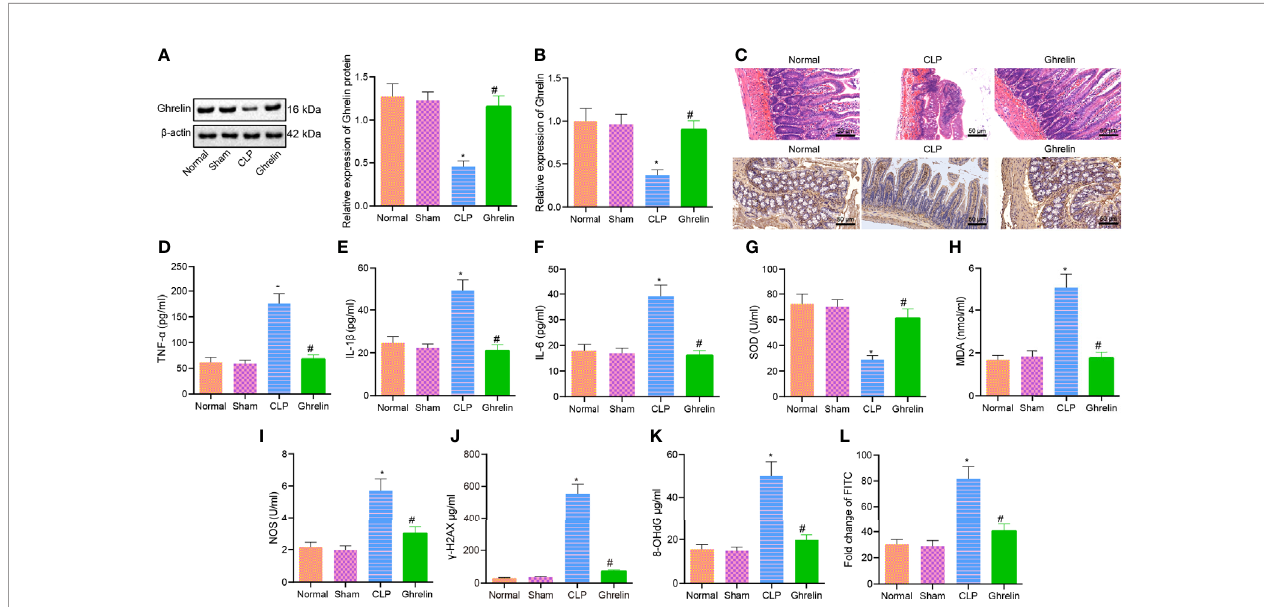
FIGURE 2 | Exogenous Ghrelin inhibits the occurrence of intestinal dysfunction in sepsis. (A) , Ghrelin expression in small intestine as examined by Western blot analysis. (B) , Detection of Ghrelin expression in small intestine by RT-qPCR. (C) , H&E staining and immunohistochemical staining for Ghrelin protein detection of small intestine (×200). (D) , Detection of TNF- a protein level by ELISA. (E) , Detection of IL-1 b protein level by ELISA. (F) , Detection of IL-6 protein level by ELISA. (G) , Detection of MDA level in small intestine. (H) , Detection of SOD level in small intestine tissue. (I) , Detection of NOS level in small intestine tissues. (J) , Detection of g -H2AX protein level in small intestine tissues. (K) , Detection of 8-OHdG protein level in small intestinal tissues. (L) , Detection of small intestinal permeability. * p < 0.05 vs. normal or sham group. # p < 0.05 vs. CLP group. The measurement data were expressed as mean ± standard deviation. One-way ANOVA was used for the comparison among multiple groups, followed by Tukey ’ s post hoc